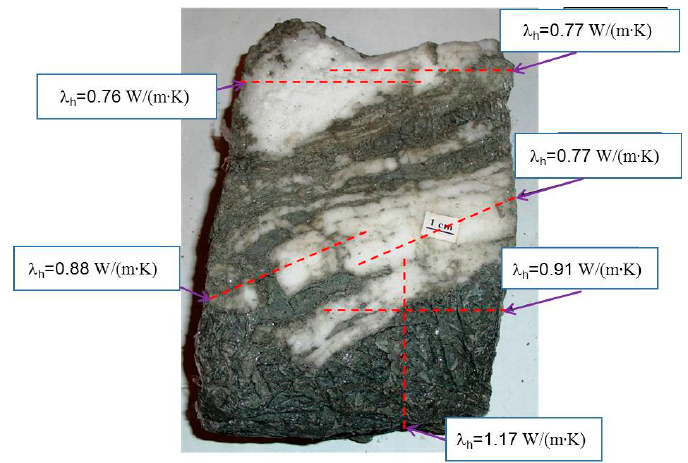
Figure 7. Thermal conductivity variations with the direction of measurements in sample S-3 containing pore ice and hydrate.